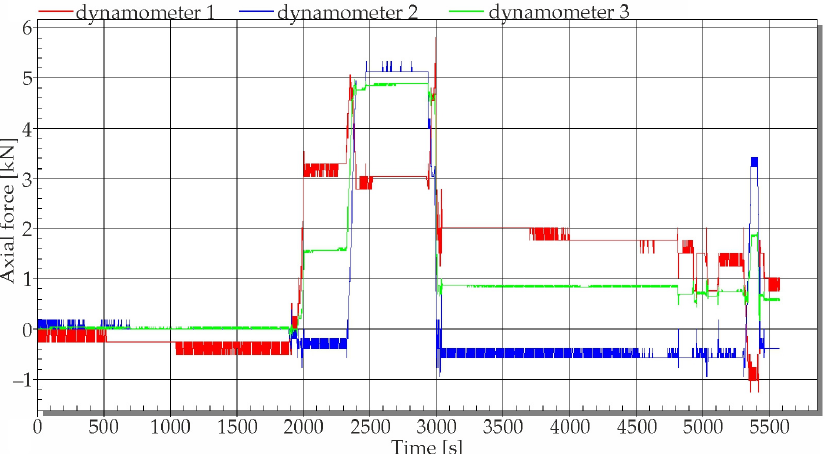
Figure 9. Recording of time changes of axial forces when rotating the casting pedestal with empty baskets.